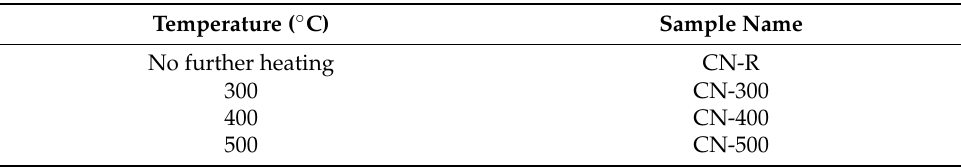
Table 1. Sample designation and applied